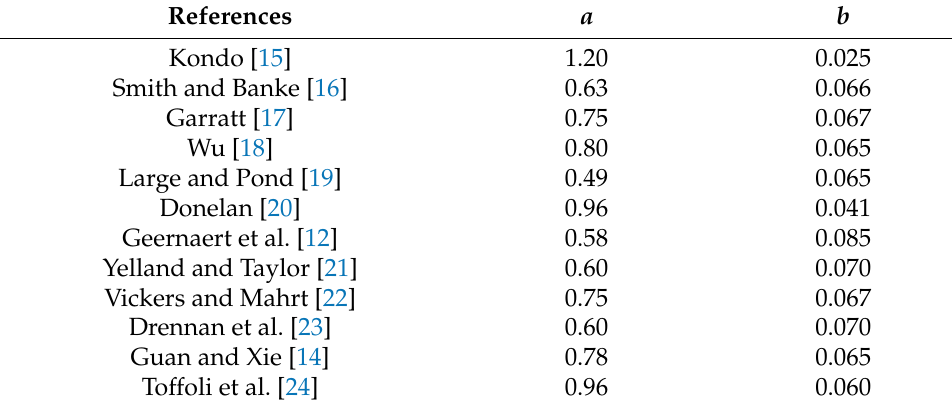
Table 1. Coefficients a and b in Equation (4) from different